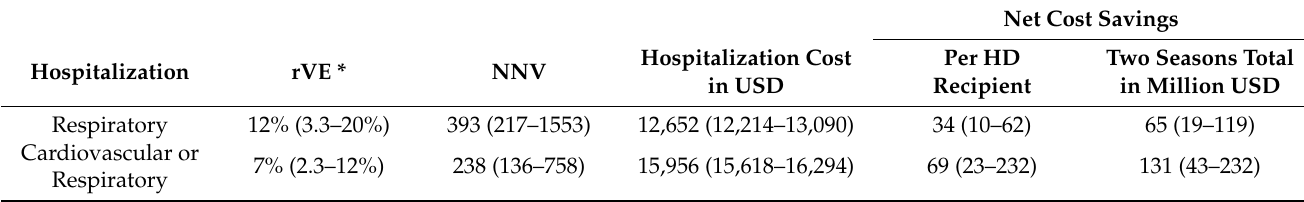
Table 2. Relative vaccine effectiveness, number needed to vaccinate (NNV), and net cost savings for members of a large national managed health care company in the U.S. during respiratory seasons 2016/17 through